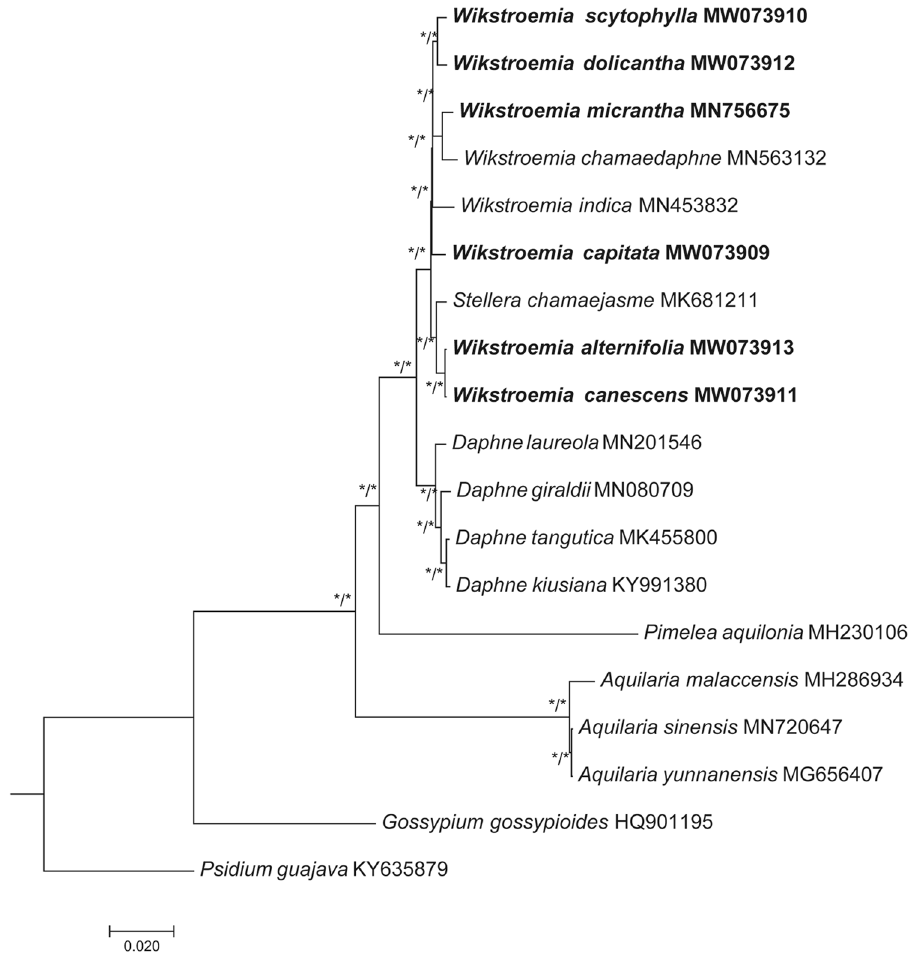
Figure 7. Maximum likelihood (ML) and Bayesian inference (BI) of Wikstroemia and allied genera based on the complete plastome sequences excluding the inverted repeat A (IRa) region, and a dataset of the intergenic spacer (IGS) regions of 17 taxa representing 5 genera of Thymelaeaceae, analysed separately. Branch nodes that were calculated with reliable support values (ML: bootstrap ≥ 75%; BI: posterior probability ≥ 0.90) are indicated with an asterisk (*). Sequences obtained through this study are indicated in bold; two species, Psidium guajava (KY635879) and Gossypium gossypioides (HQ901195), were included as